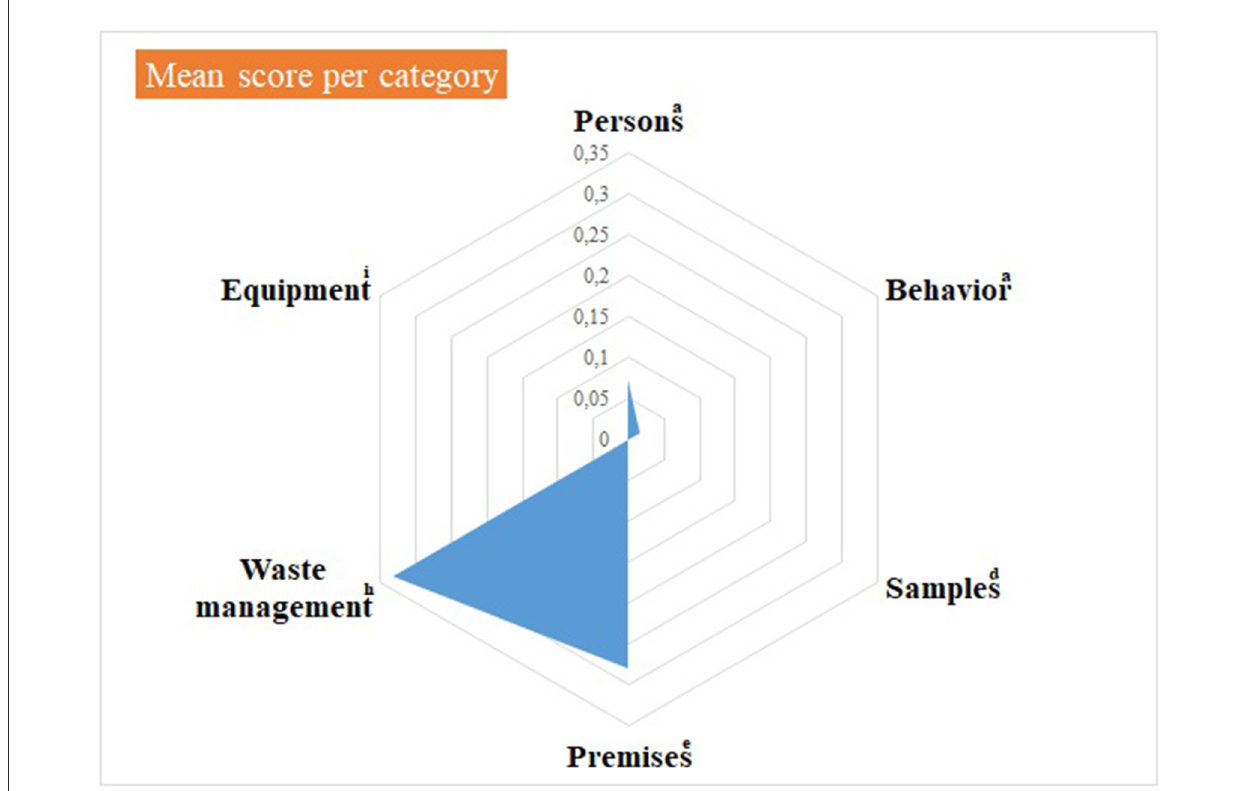
FIGURE4 Virology practical sessions—mean score per component of the internal biosecurity audit. a For the categories “Persons” and “Behavior”, N observations ( = number of people observed per category) = 14 students of 2nd bachelor in veterinary medicine (BVM2) and 4 scientific and technical staff members. d For the category “Samples”, N observations = 1; e For the category “Premises”, N observations = 1 (the lab itself, its preparation for practical activities and cleaning and disinfection process): h For “Waste management”, N observations = 1 (waste disposal equipment present in the lab and anteroom). i For “Equipment”: N observations = 1 for the management of the lab equipment (lab equipment and preparation procedure) and N = 14 for movements of equipment. The number of observations per item appears in Supplementary material